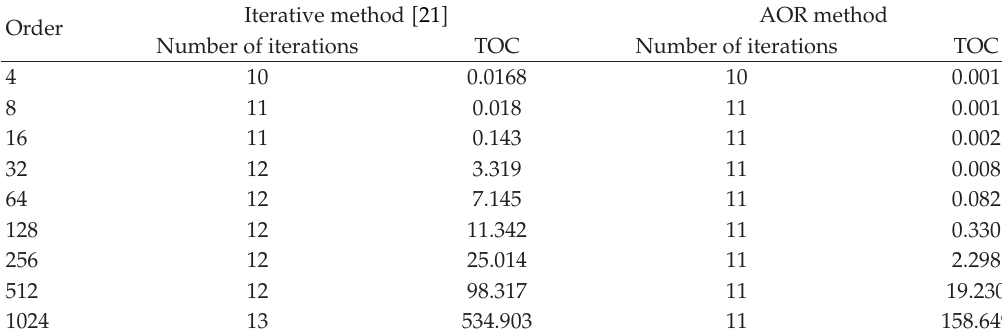
Table 2: Computational